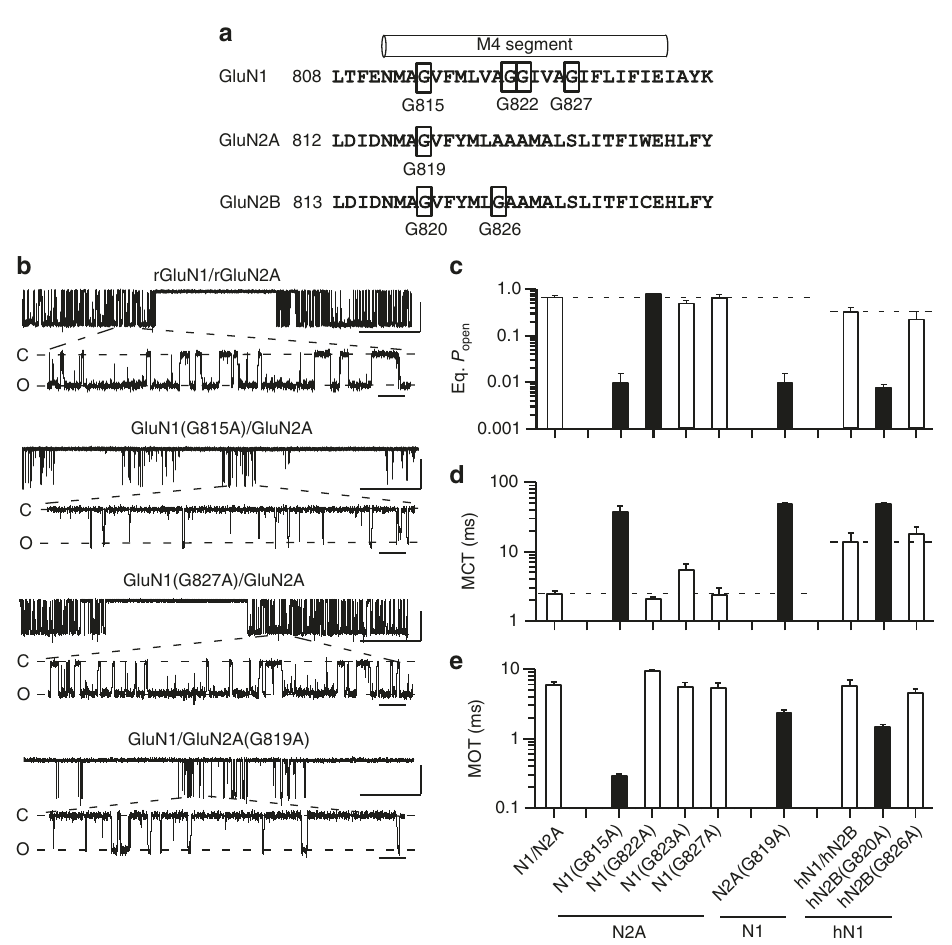
Fig. 5 Alanine substitutions of glycine in the M4 segments reveal that the conserved glycine has a unique functional role in gating. a Sequence of M4 segments and adjacent regions highlighting glycines. b Example single channel recordings in the on-cell con fi guration of wild type rat GluN1/GluN2A and various receptors containing glycine-to-alanine substitutions. Recordings displayed as in Fig. 3a. Scale bars: 5 pAs for all; time base is 500 ms (upper trace for each construct) and 20 ms (lower trace for each construct). c – e Mean ± SEM ( n > 4 patches) showing equilibrium open probability (eq. P open ) ( c ), mean closed time (MCT) ( d ), and mean open time (MOT) ( e ) for alanine substitutions of glycines in the M4 segments of rat GluN1 and GluN2A and human GluN1 (hGluN1) and GluN2B (hGluN2B) (Supplementary Table 4). Solid bars indicate values signi fi cantly different from their